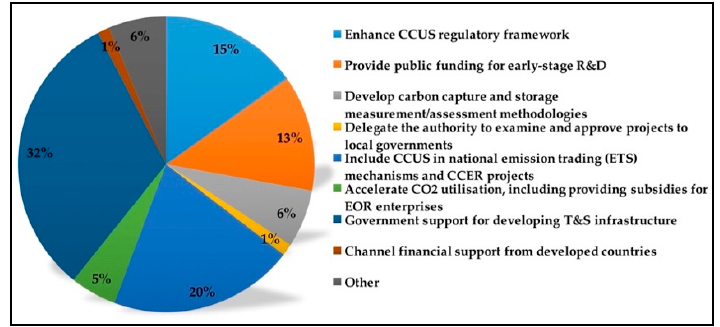
Figure 10. Regulatory/financial enablers of CCUS steel projects.